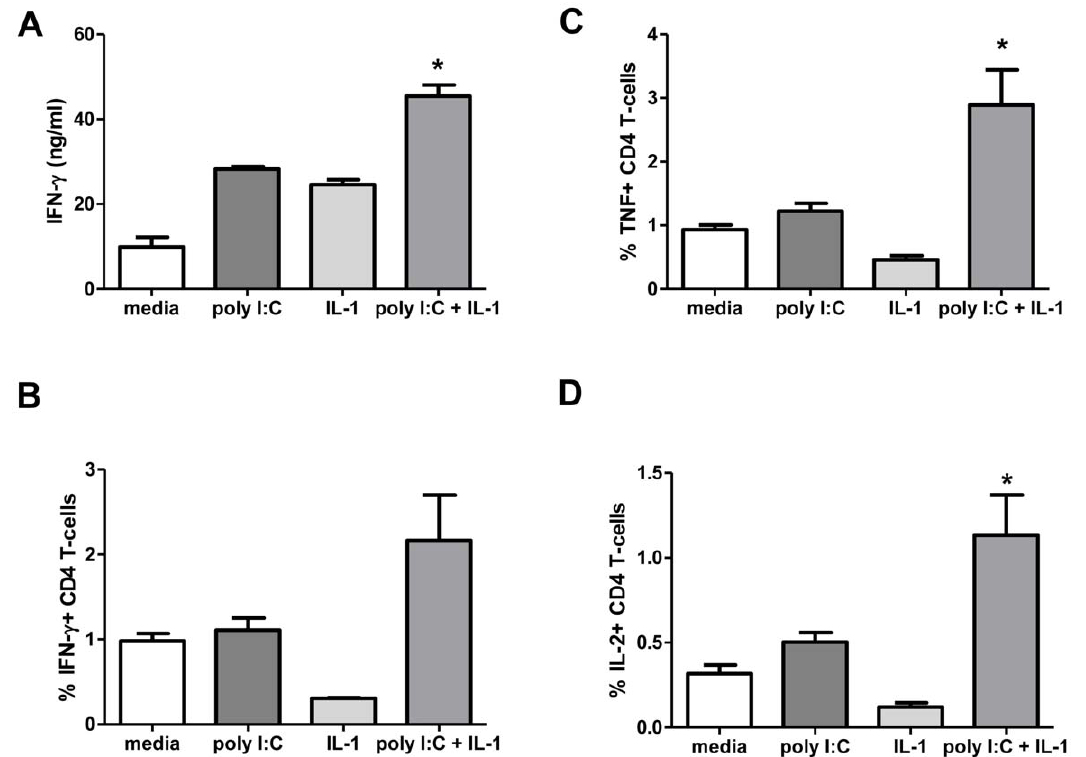
Figure 6. The addition of rIL- 1 a and rIL-1 b increases poly I:C-induced CD4 + Th1 responses in a cDC/CD4 + T-cell MLR. (A) Cell culture supernatant IFN- c levels in poly I:C stimulated MHC congenic MLR with mouse rIL- 1 a and rIL-1 b . ICS staining for IFN- c (B), TNF- a (C) and IL-2 (D) producing conventional CD4 + T-cells. Values are mean 6 SEM (n=3) (representative of two independent experiments shown). *p , 0.05 compared to media control.